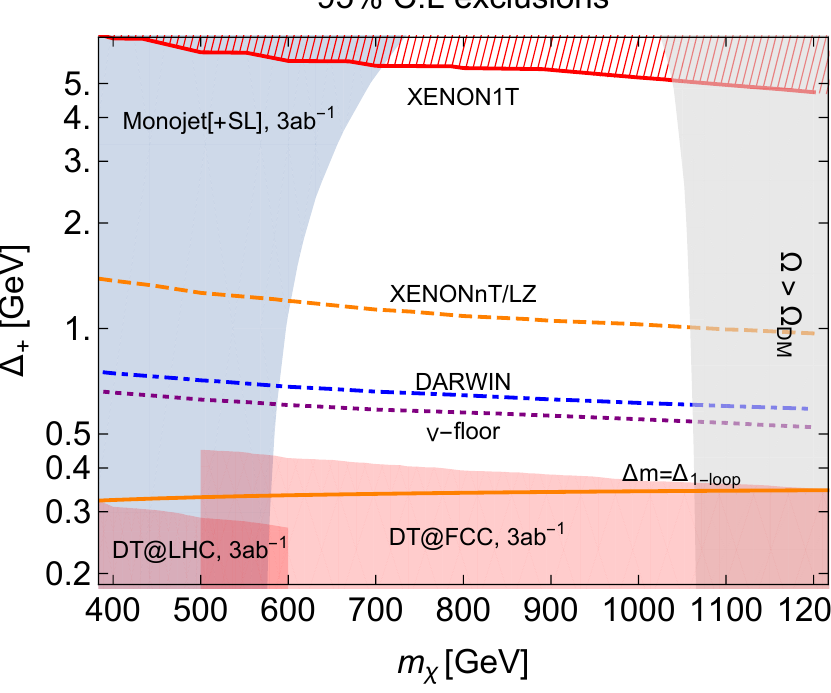
Figure 7 . Status of the higgsino parameter space in view of current and future experimental constraints. We show the FCC monojet reach [5] (blue shaded) and the FCC disappearing track reach [23] (red shaded), for an integrated luminosity at FCC-hh of 3 ab (cid:0) 1 ; as well as the region where the thermal relic overcloses the universe (grey shaded). The limit on the spin-independent direct-detection cross section due to the recent XENON1T results [59] is denoted by a red line, with the diagonal-(cid:12)lled region above the line excluded. The dashed and dash-dotted lines correspond to the sensitivity of future direct -detection experiments, with the splittings at which the neutrino (cid:13)oor becomes relevant shown in purple short dashes. The solid orange line corresponds to the nominal 1-loop electroweak